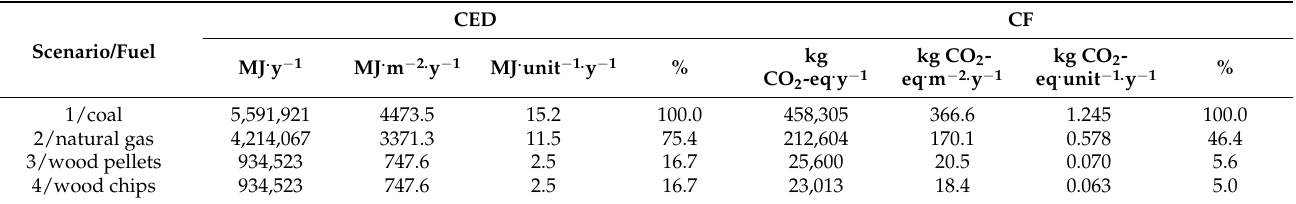
Table 6. CED and CF for individual scenarios expressed as absolute values, as well as specific values per unit area and per unit of a potted